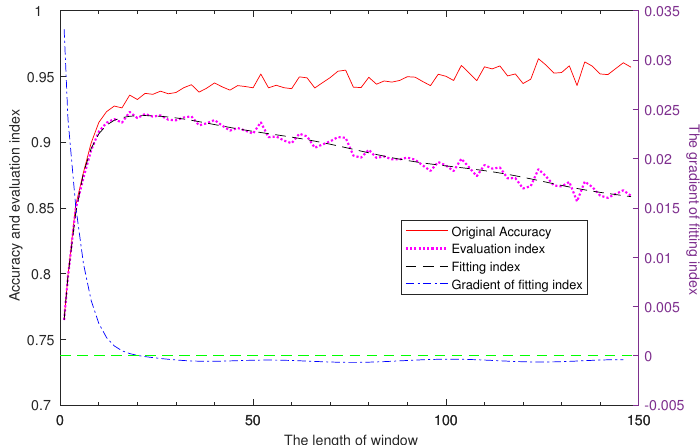
Figure 2. Analysis of the real time strategy. There are four curves in this figure, respectively corresponding to (——–) original Accuracy, the accuracy of the two-layer LSTM network where the window length range from 1 to 150; ( ◾ ◾ ◾ ◾ ) evaluation index, the index designed to select the length of window; (– – –) fitting index, a thirteen-order polynomial used to fit the evaluation index function; (– - – - –) gradient of fitting index, the gradient of the fitting index. The first three curves refer to the left Y -axis while the last curve takes the right Y -axis as